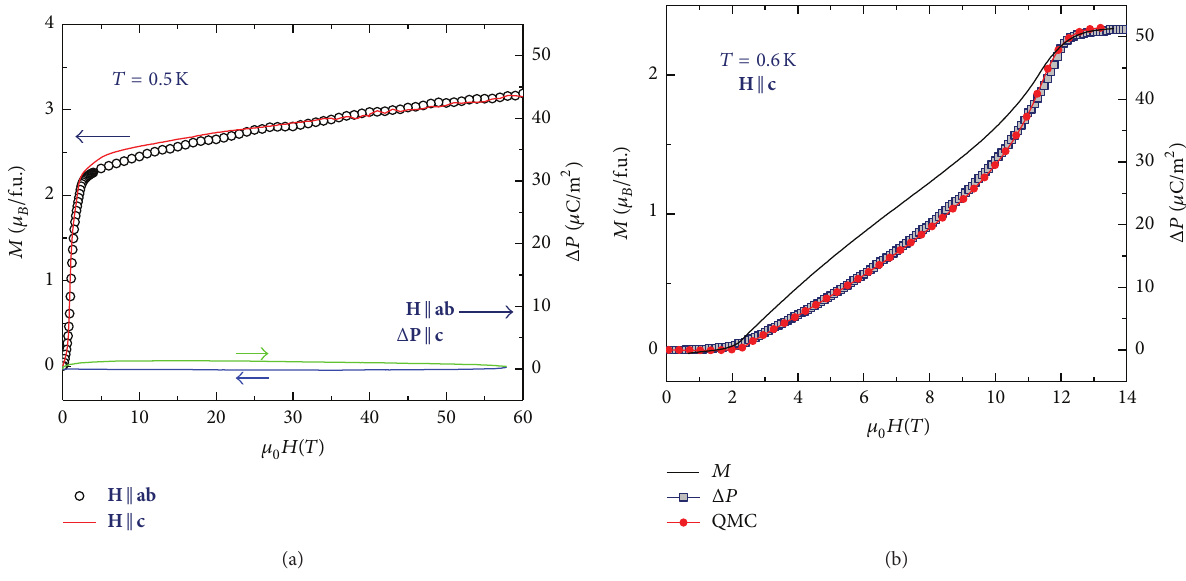
Figure 3: (a) CoCl 2 -4SC(NH 2 ) 2 . Left axis: magnetization isotherms 𝑀(𝐻) at 𝑇 = 0.5 K for H ‖ ab (open circles) and H ‖ c (solid line). Right axis: electric polarization change Δ𝑃(𝐻) at 𝑇 = 0.5 K for H ‖ ab and Δ P ‖ c . The horizontal small arrows indicate the up- and down-sweeps of the magnetic field. (b) NiCl 2 -4SC(NH 2 ) 2 . Left axis: 𝑀(𝐻) at 𝑇 = 0.6 K for H ‖ c (solid line). Right axis: Δ𝑃(𝐻) at 𝑇 = 0.6 𝐾 for H ‖ c (solid squares) and quantum Monte Carlo (QMC) calculations of the electric polarization (solid circles)